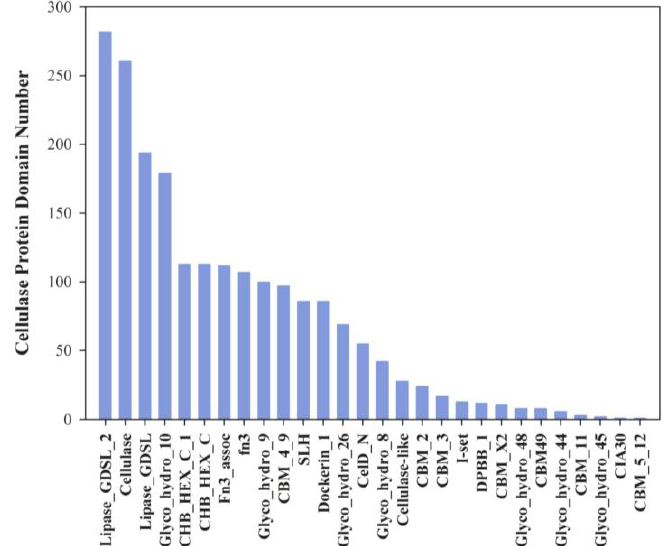
Supplementary Figure 2. Richness of each protein domain with cellulase activity in the goat rumen microbial